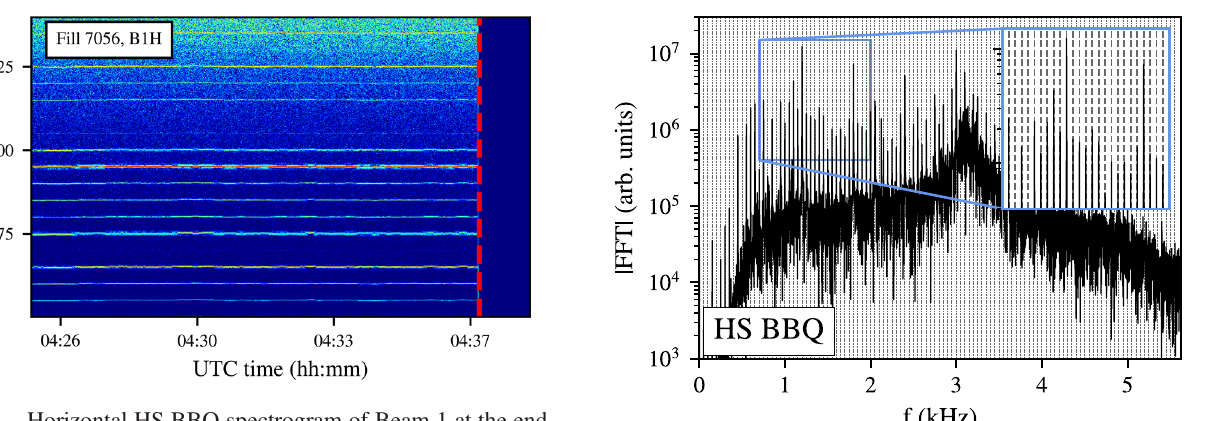
FIG. 2. Horizontal HS BBQ spectrogram of Beam 1 at the end of a physics fill (Fill 7056), centered around 3 kHz and color- coded with the PSD. The red dashed line indicates the end of the fill and the start of the dump of the beam.